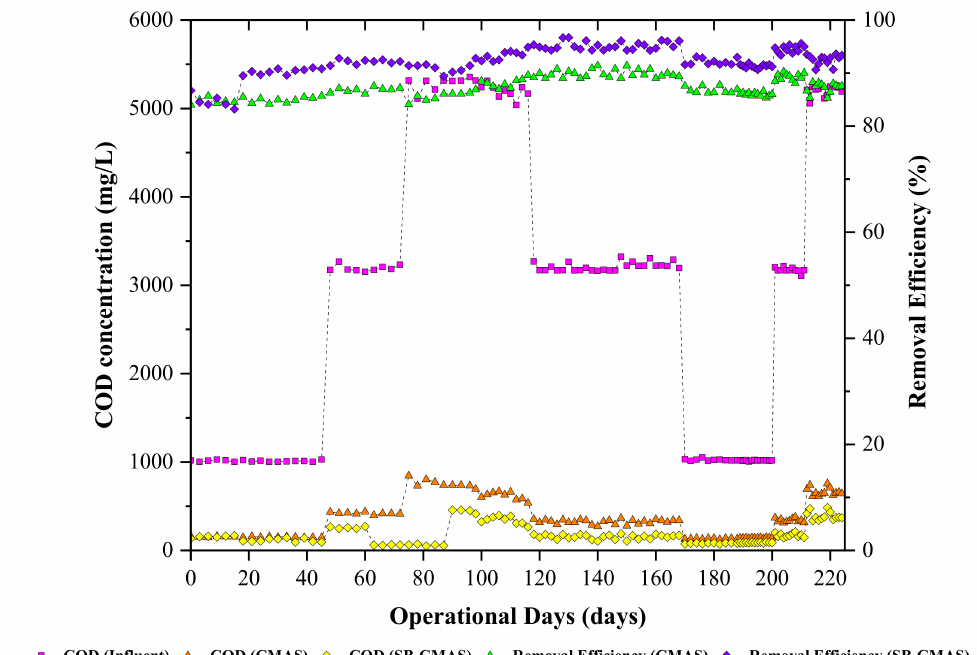
Figure 4. The CMAS and SB-CMAS bioreactor results in terms of COD concentrations and their removal